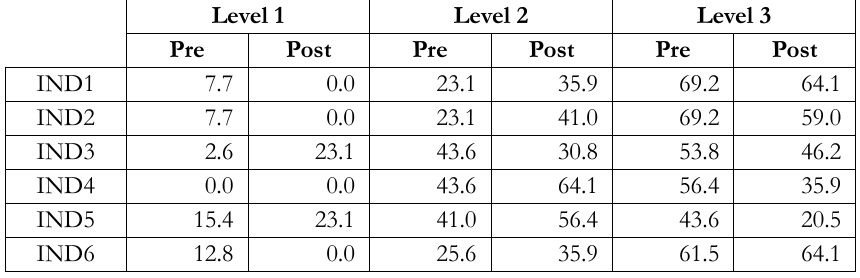
Table 7. Comparison of teamwork perceptions prior to and following intervention in the EG (values given as a percentage of the total,